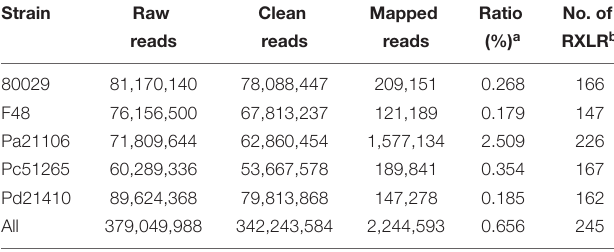
TABLE 1 | Deep sequencing data.